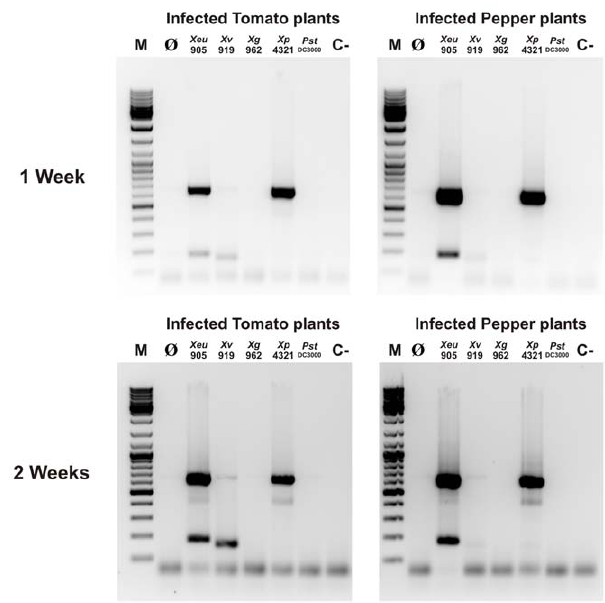
Figure 5. Detection of BSX in infected plant material using a duplex PCR (markers XV7 and XV11). Tomato and pepper plants inoculated with Xeu 905, Xv 919, Xg 962 and Xp 4321were processed after one and two weeks to obtain crude bacterial suspensions used as PCR templates. Plants inoculated with Pst DC3000 were used as controls. M – DNA marker (GeneRuler DNA Ladder Mix); Ø-Duplex PCR using distilled water as template; C- healthy tomato and pepper plants.